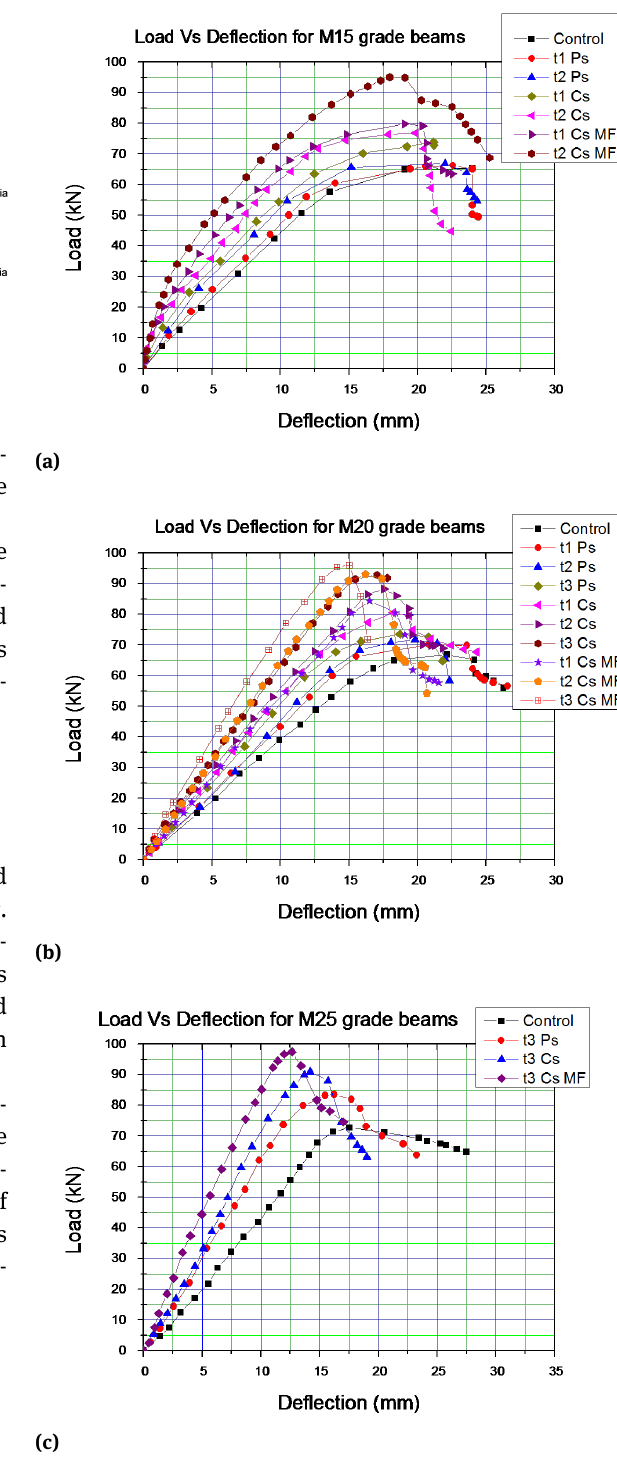
Figure 6: Load Verses Mid span Deflection for beams casted